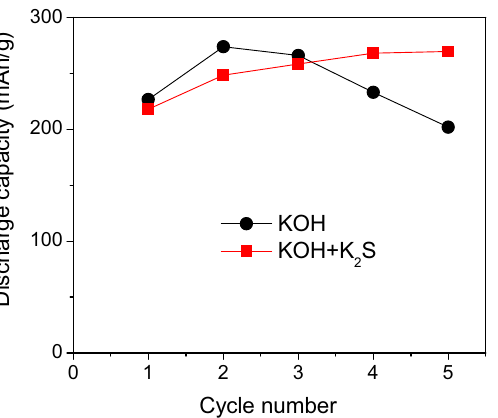
Figure 5. Discharge capacities of Fe 2 O 3 /AB electrodes with Fe 2 O 3 cube in KOH and KOH + K 2 S solutions.